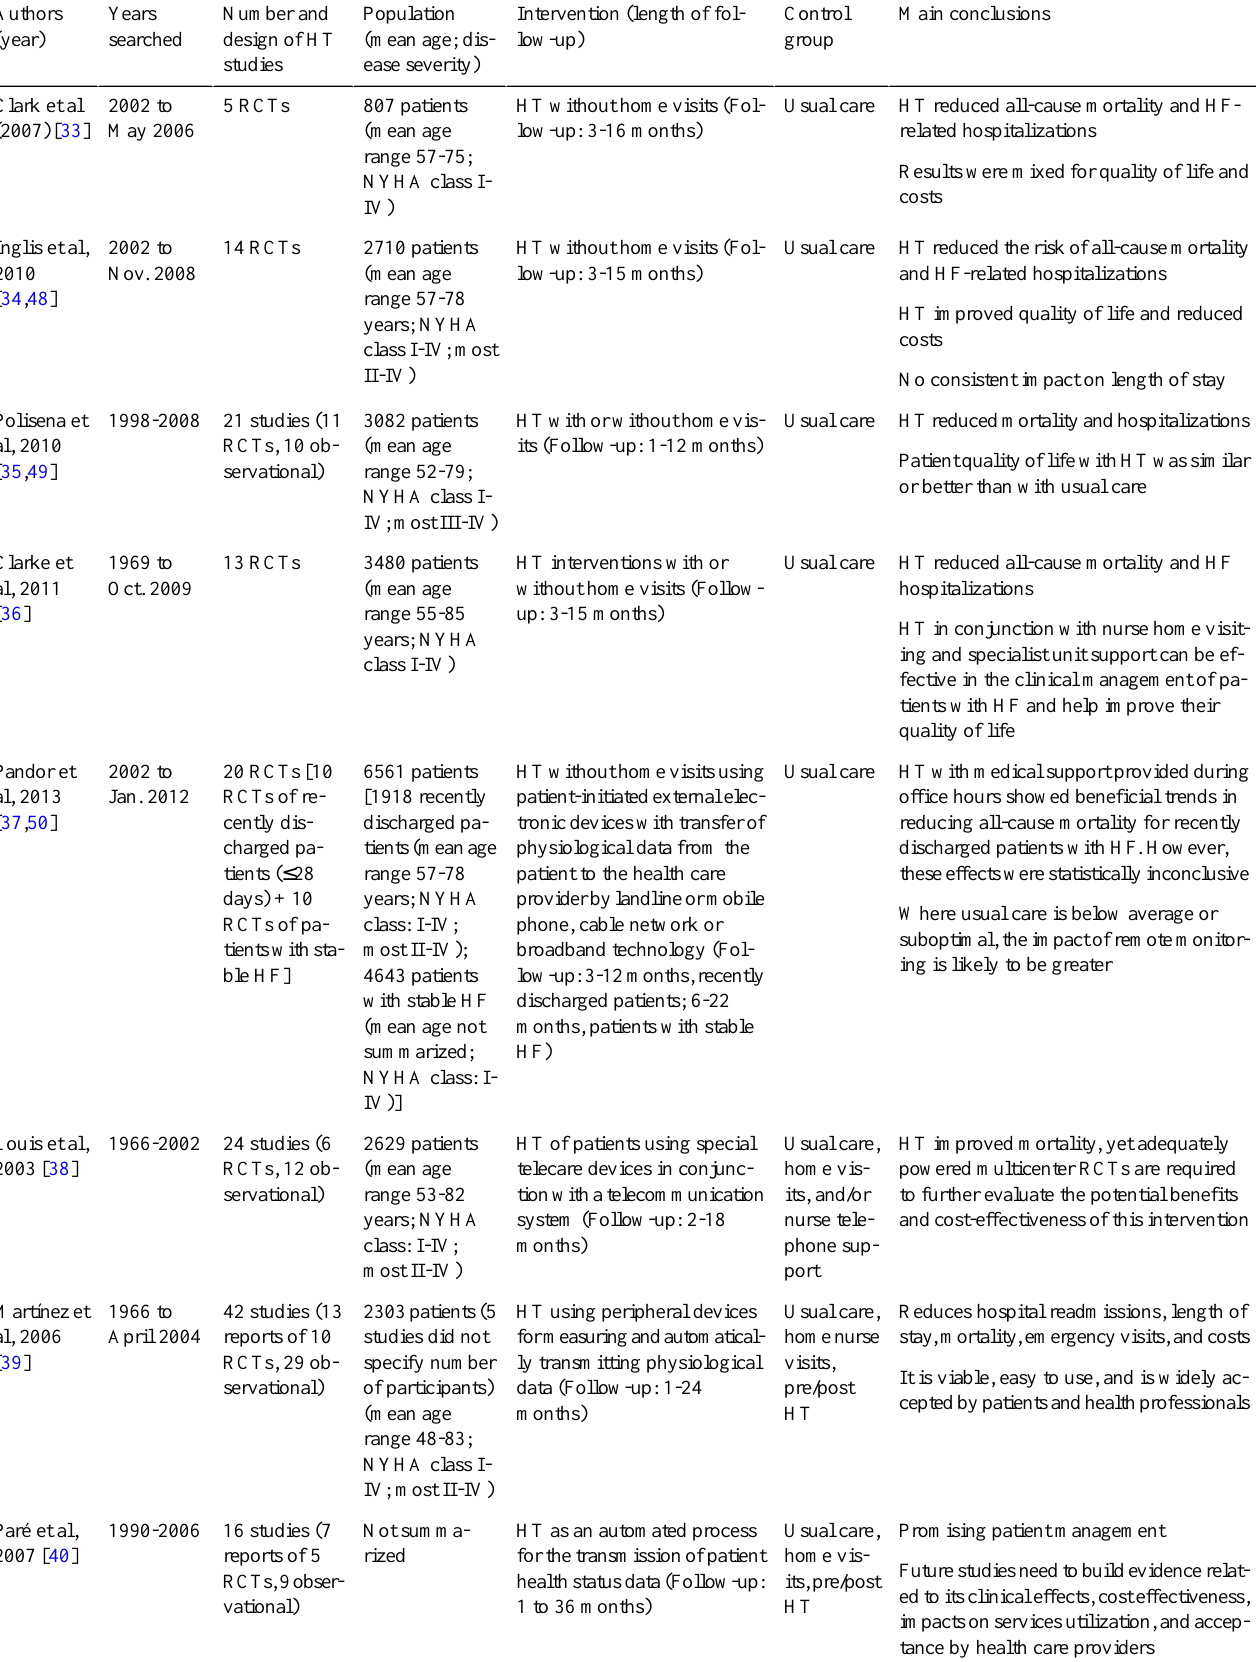
Table 2. Characteristics of included systematic